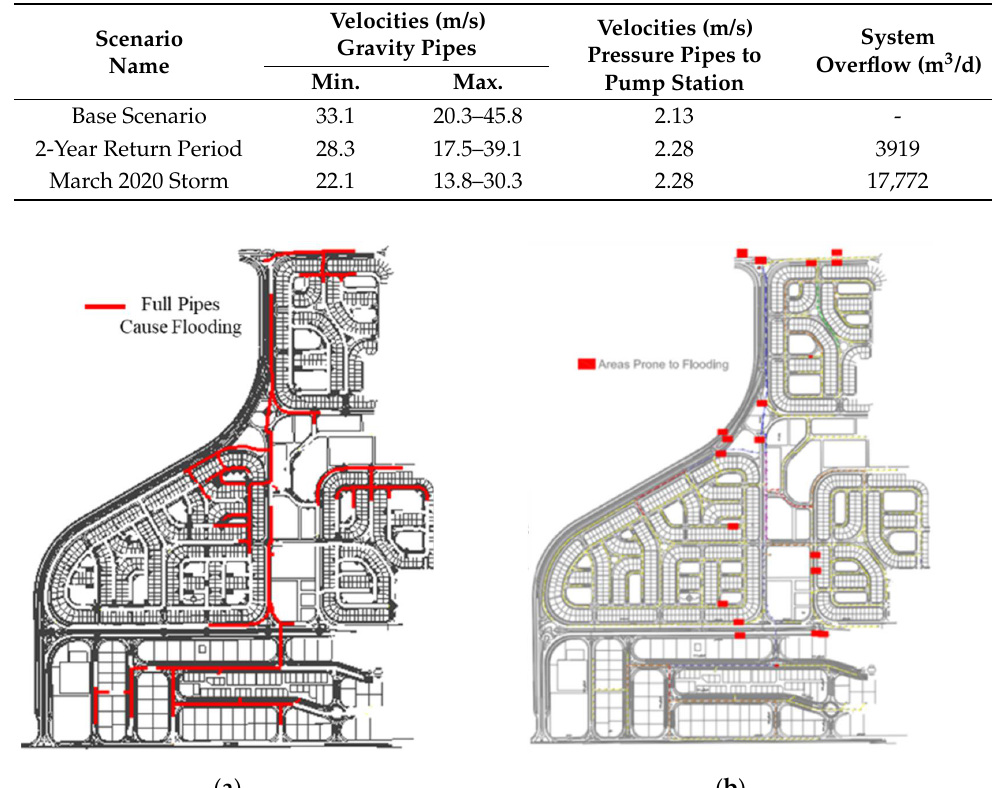
Figure 12. ( a ) Percentage used of the drainage network at different scenarios; ( b ) percentage used of the pump stations with different return periods. Shown for all 17 neighborhoods. * These areas had planned upgrade and the extra capacity was added in the calculations. Table 8. Comparison of return period intensities between the periods of 1976 to 1999 and 2000 to 2020.